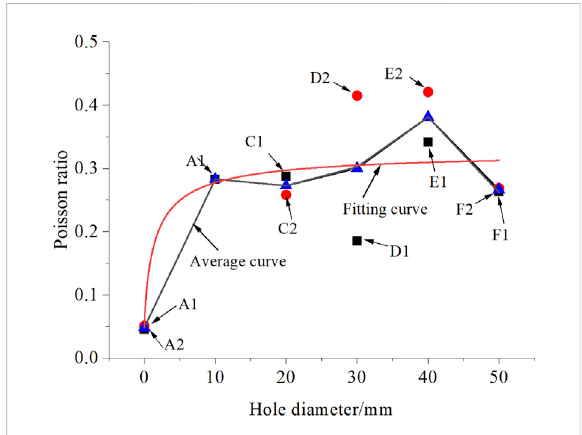
FIGURE 10 Relationship between the hole diameter and Poisson ratio.